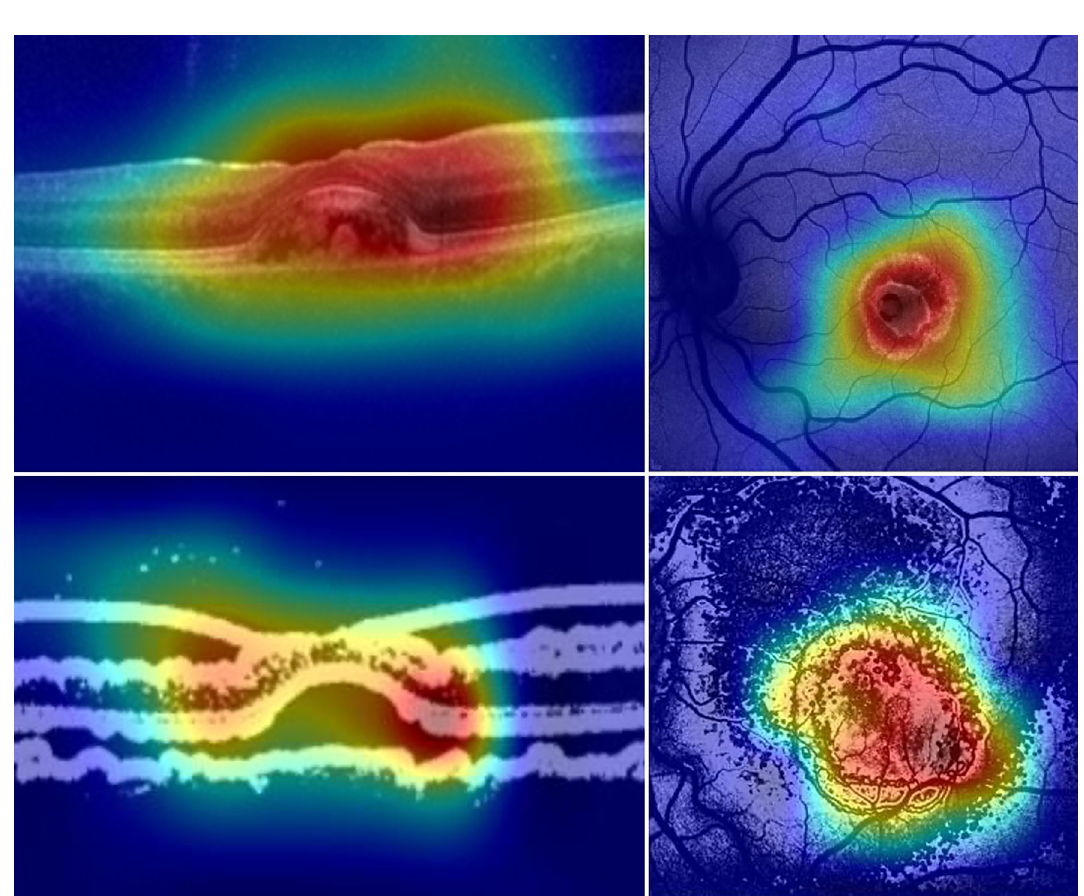
Figure 4. GradCAM output highlighting relevant features for each of the 4 deep learning classifiers. Upper left: deep learning classifier for unprocessed OCT images; Upper right: deep learning classifier for unprocessed BAF images; Lower left: deep learning classifier for OCT processed images; Lower right: deep learning classifier for BAF processed images. BAF blue autofluorescence, OCT optical coherence